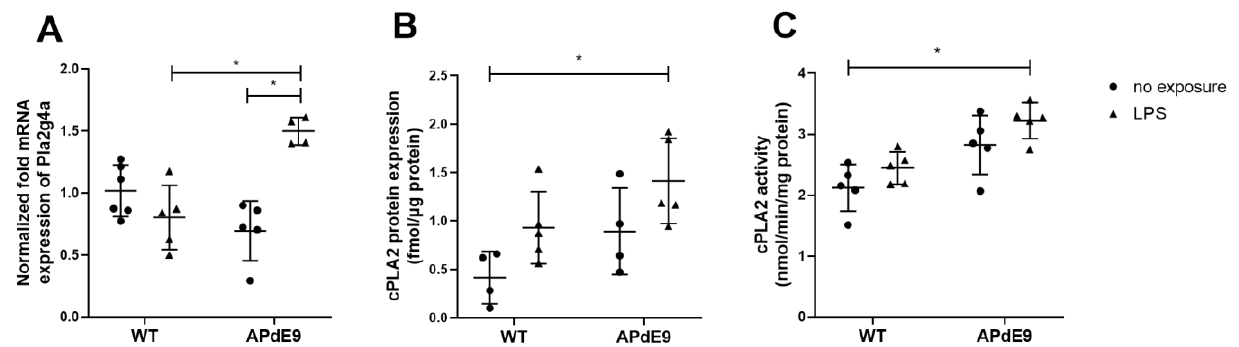
Figure 1. Comparison of normalized fold mRNA expression of Pla2g4a ( A ), absolute protein ex- pression levels of cPLA2 α ( B ) and cPLA2 enzyme activity ( C ) in the cerebral cortical tissue in saline-treated female wild-type (WT) control mice vs. female WT mice treated with LPS, and female APdE9 mice treated with either saline or LPS. The line represents group mean and whiskers—the SD ( n = 4–6 per group). The statistical significance of changes in cPLA2 gene and protein expressions as well as the activity between the groups was analyzed by a Kruskal–Wallis test followed by a Dunn’s multiple comparisons post-hoc test. Statistically significant differences are marked with asterisks, where * indicates p < 0.05.